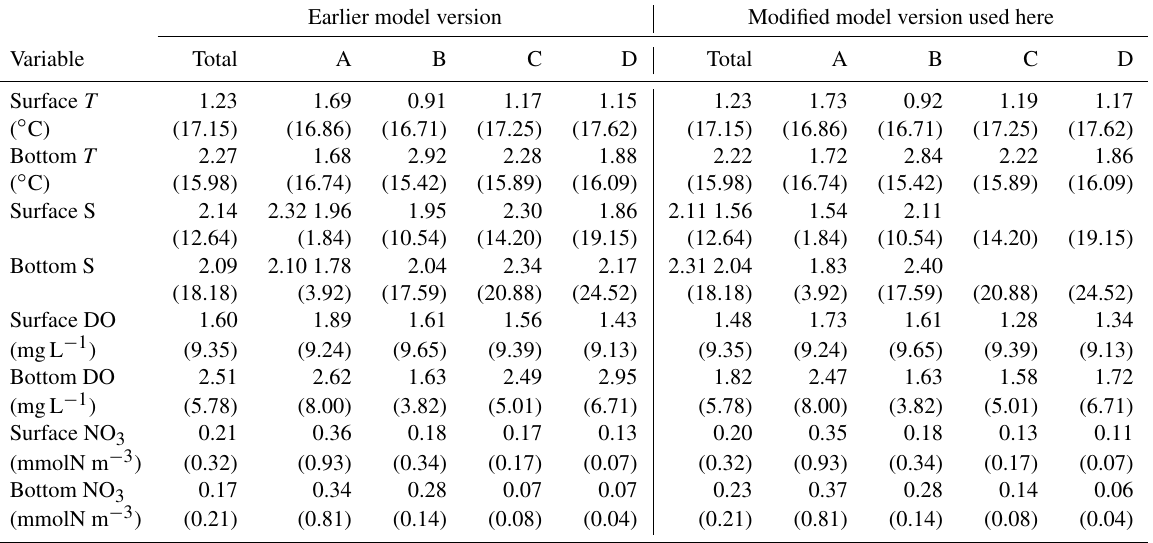
Table A3. Total RMSD (and observational mean) of surface and bottom temperature ( T ), salinity ( S ), dissolved oxygen (DO), and nitrate (NO 3 ) of the present model and the earlier model version used in Feng et al. (2015) and Irby et al. (2016) for the four regions (A, B, C, D) defined in Fig.